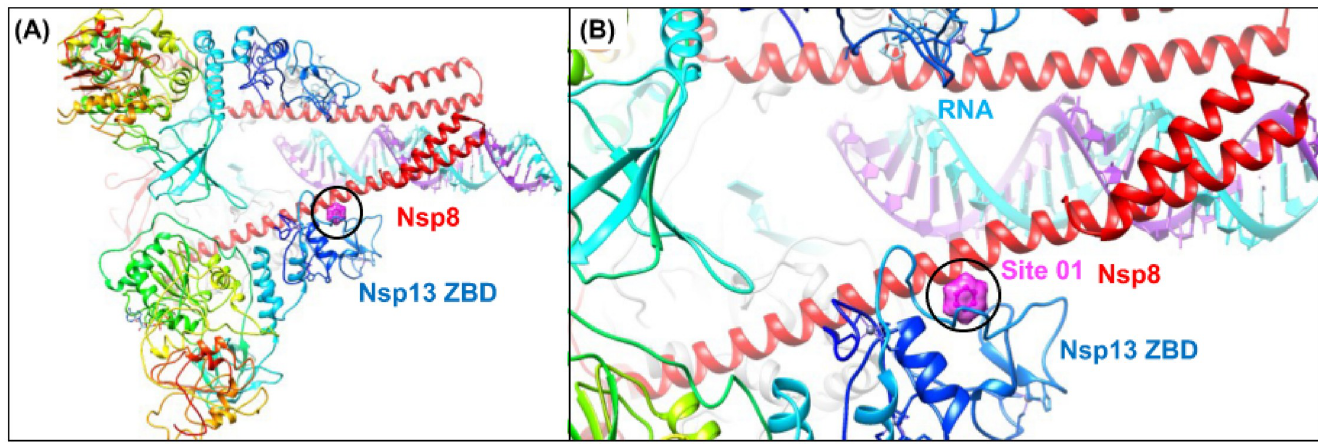
Fig 13. Structure of the Nsp12: Nsp13 replication transcription complex reveals that the Nsp13 zinc-binding-domain (ZBD) mediates protein-protein interactions. (A) A ribbon diagram of the structure of the complex (6xez.pdb) [61] shows how two subunits of the helicase form protein-protein interactions with both Nsp8 (red) and Nsp12 in the active complex through interactions with the helicase ZBD domain (blue). (B) A zoom in view shows that the previously predicted Site 01 on the ZBD (magenta) is proximal (within 5–6 Å ) to the Nsp8:Nsp13 protein-protein interaction site in the replication complex.